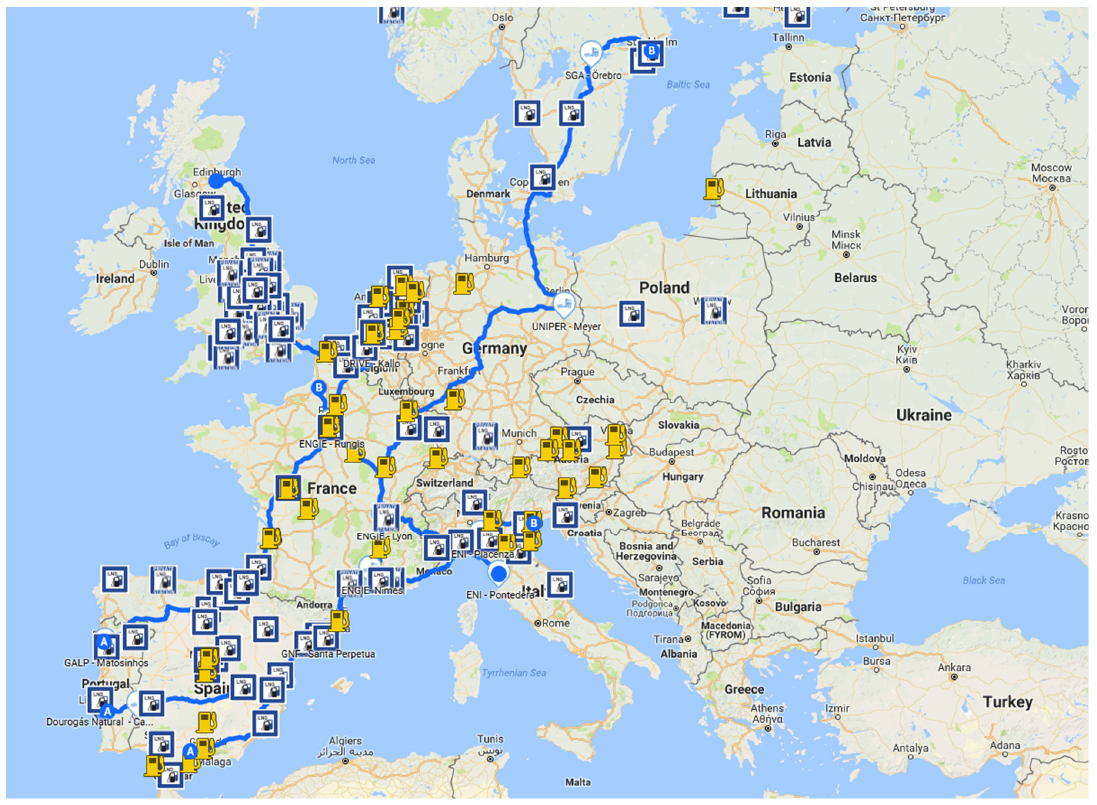
Figure 1. Current and planned LNG filling stations in Europe (EU) [63].